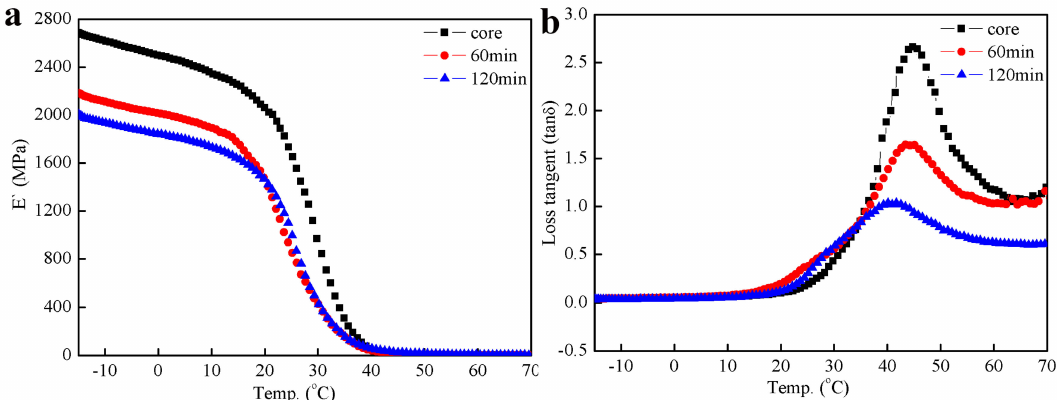
Figure 6. DMA curves of the composite emulsions with different shell polymerization times; ( a ) storage modulus, E (cid:48) (MPa), ( b ) loss factor, tan δ